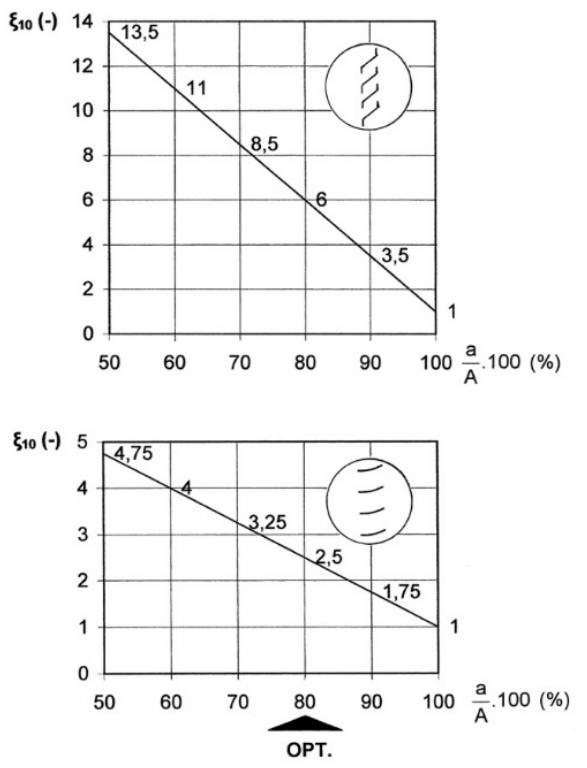
Figure 8: Basic geometry of a double skin facade.